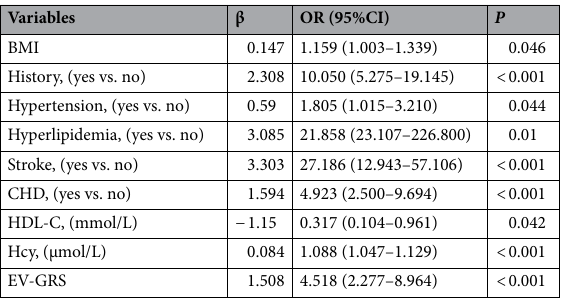
Table 3. The multinomial logistic analysis between success group and failure group in training set. CHD coronary heart disease, HDL-C high density lipoprotein cholesterol, Hcy